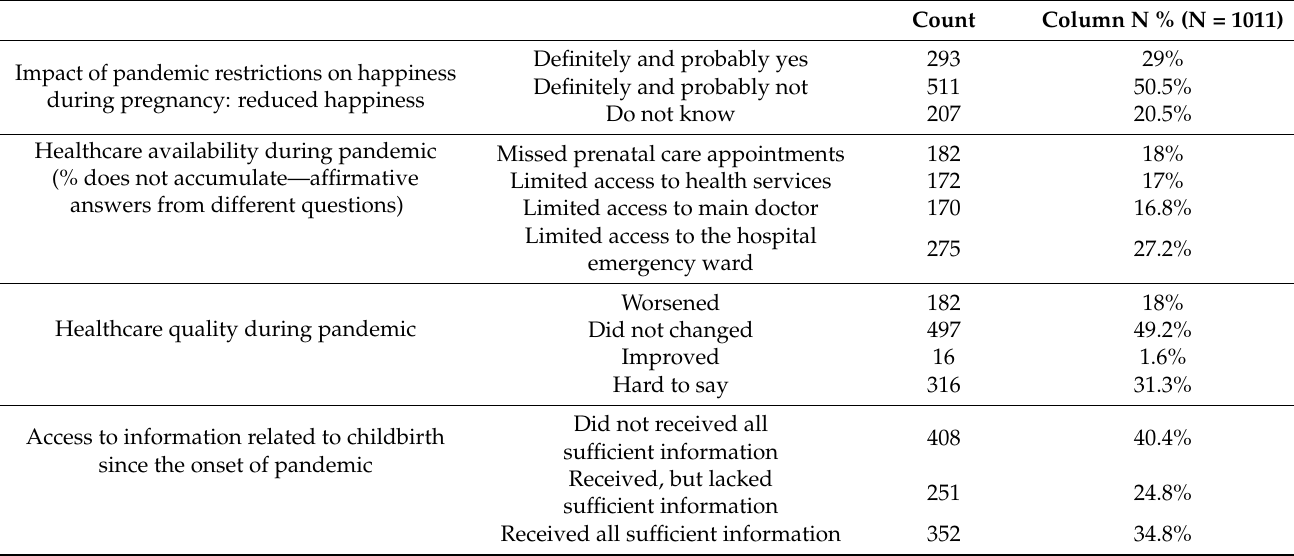
Table 3. Effects of epidemic